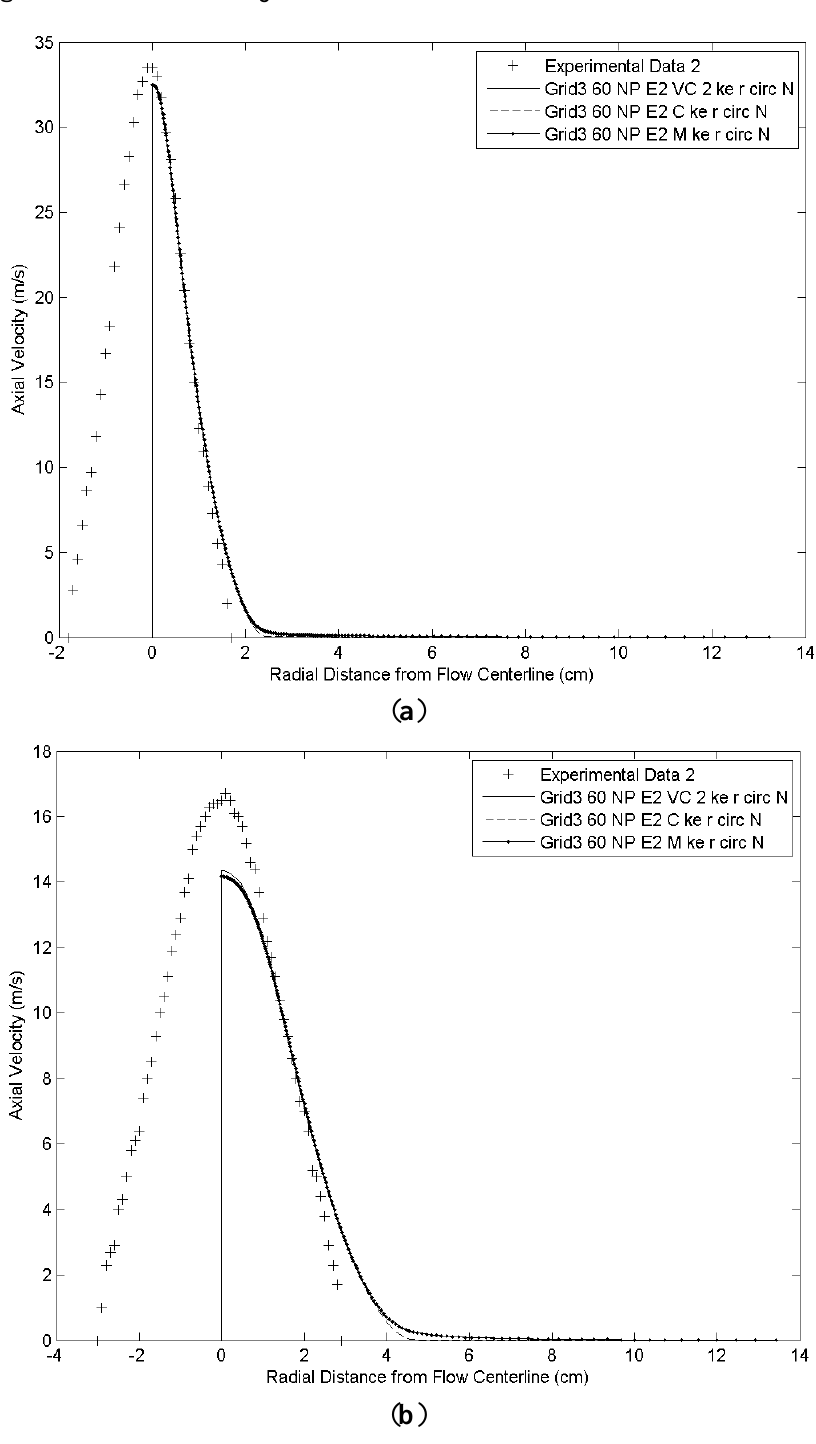
Figure 14. Velocity profiles ( a ) at 10 cm from the origin of the annular air jet; ( b ) at 20 cm from the origin of the annular air